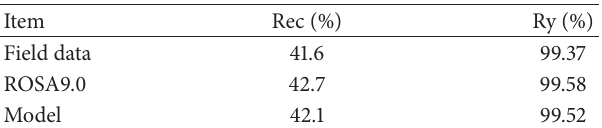
Table 2: Comparison of the actual performance with those from ROSA9.0 and our